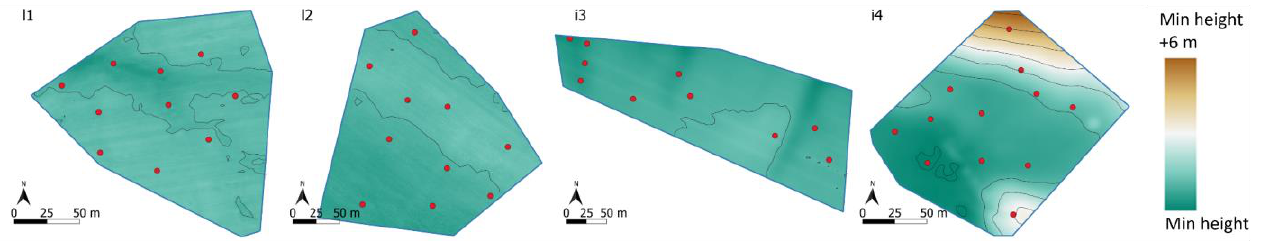
Figure 3. Locations of soil sampling points marked with red dots, and the topography (DTM produced from drone datasets) is visualized using a color scale (the minimum height for each parcel is presented in Table 1) and contour lines with 1 m intervals for the four study fields (l1, l2, i3, and i4).